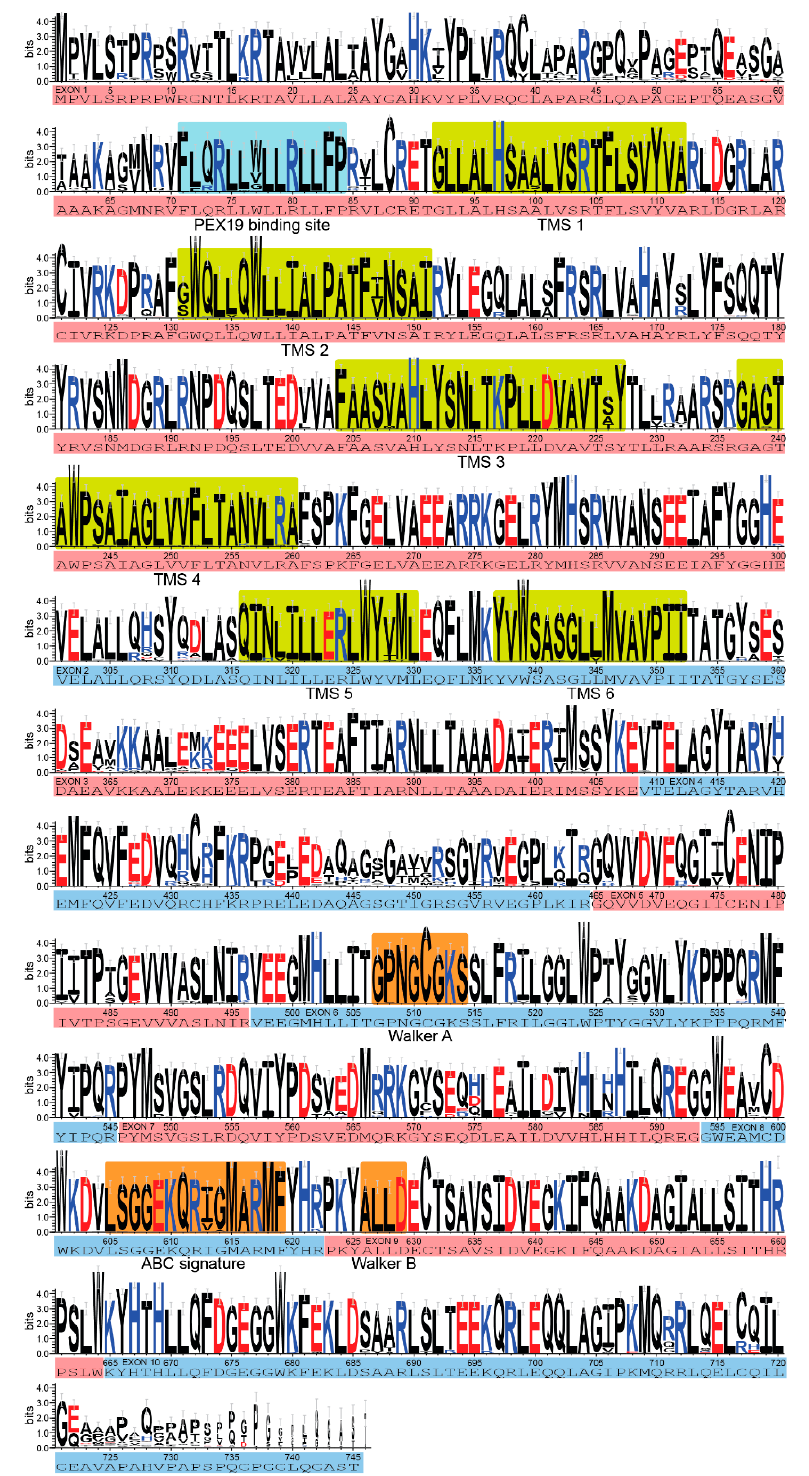
Figure 3. The evolutionary conservation of each amino acid within the ABCD1 protein based multiple sequence alignment among 54 different species. The overall height of each symbol represents the relative frequency of each amino acid at that position. Positively charged amino acids (KRH) are in blue; negatively charged amino acids (DE) are in red. Exons are indicated in alternating blue–pink–blue, etc.; the PEX19-binding site is indicated in blue; the 6 transmembrane segments are indicated in green; Walker A and B and the ABC signature are indicated in orange. Error bars indicating an approximate Bayesian 95% confidence interval are indicated in grey.